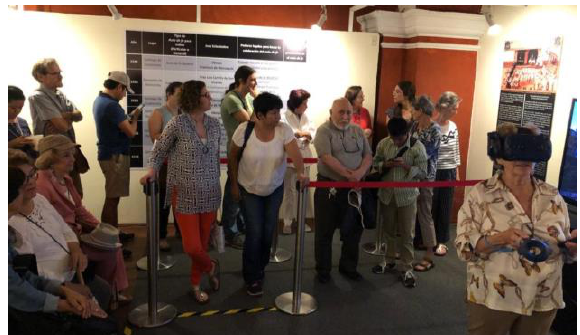
Figure. 13. A group of users waiting for their turn. July 16,